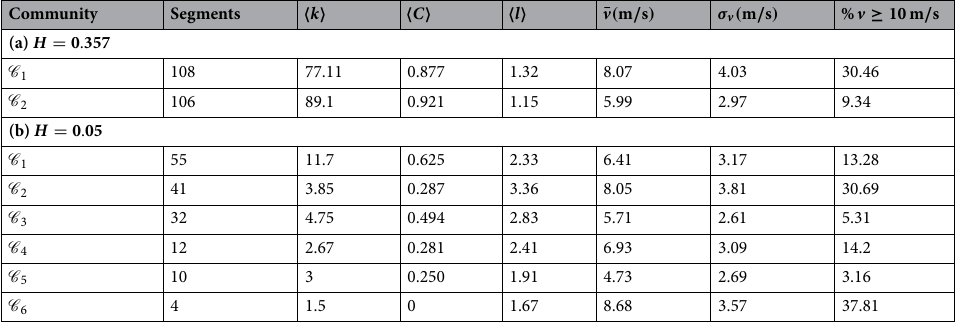
Table 1. Classification of segments using community detection. Analysis of similarity networks for (a) H = 0.357 and (b) H = 0.05 . The number of segments in each community is reported with the average degree (cid:31) k (cid:30) , global clustering (cid:31) C (cid:30) , and average lengths (cid:31) l (cid:30) of the shortest path connecting the nodes for each subnetwork. For the non-null speeds in the segments in each community ¯ v denotes the average speed and σ v the standard deviation, we also report the fraction (as percentage) of speeds with v ≥ 10m / s .